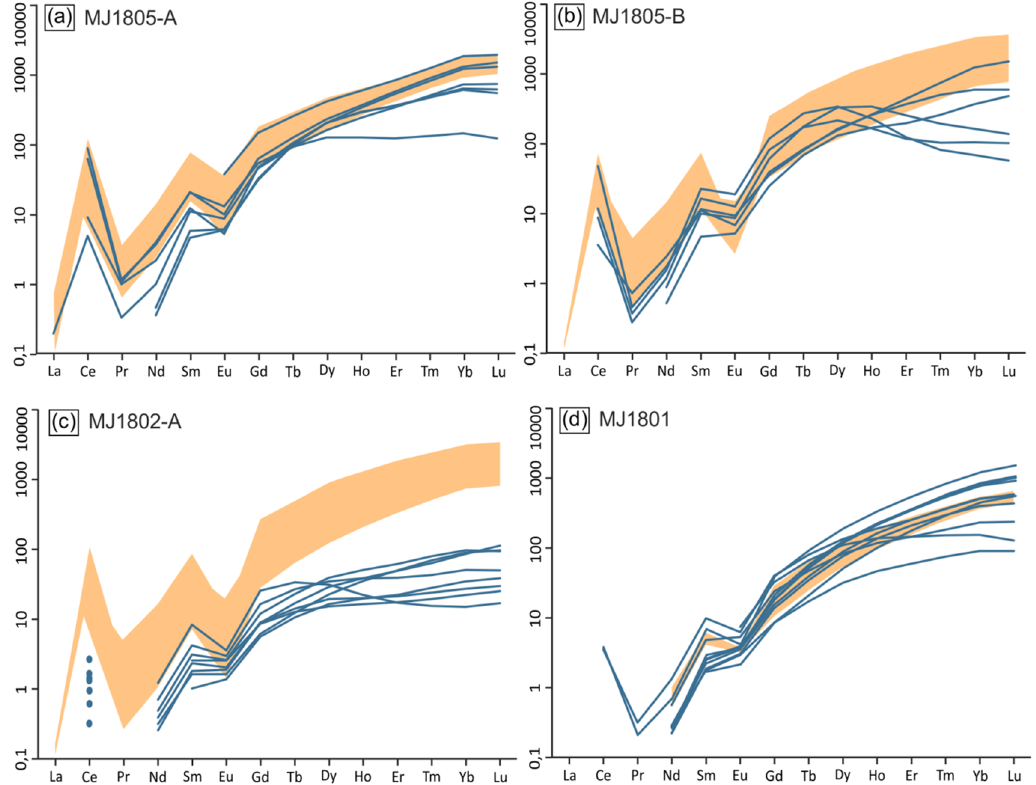
Figure 8. Chondrite-normalized REE patterns in zircon. Orange and blue lines represent zircon cores and rims, respectively. ( a ) Sample MJ18-05A: migmatitic paragneiss. ( b ) Sample MJ18-05B: migmatitic paragneiss. ( c ) Sample MJ18-02A: migmatitic paragneiss. ( d ) Sample MJ18-01: garnet amphibolite. Caledonian zircon rims from the samples MJ18-05A and MJ18-05B display two di ff erent